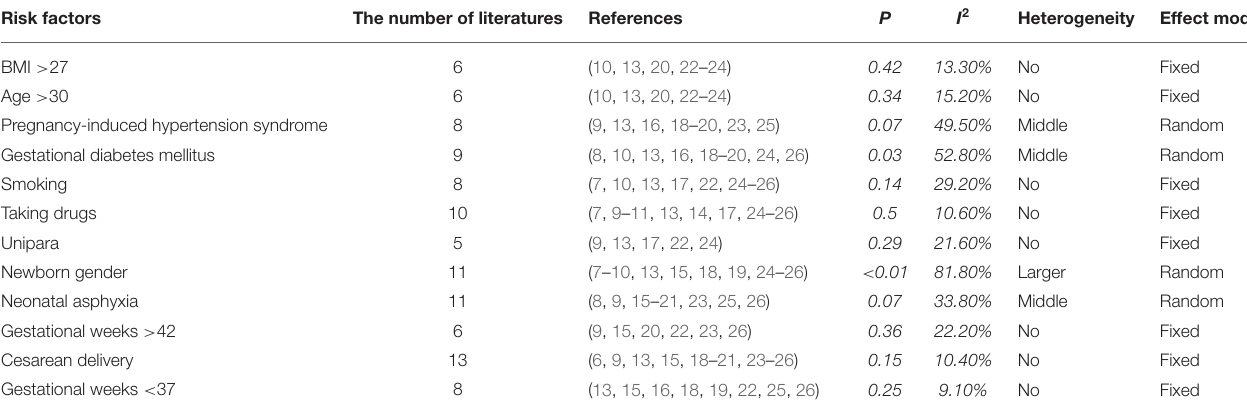
TABLE 2 | The combined literature and heterogeneity test results.